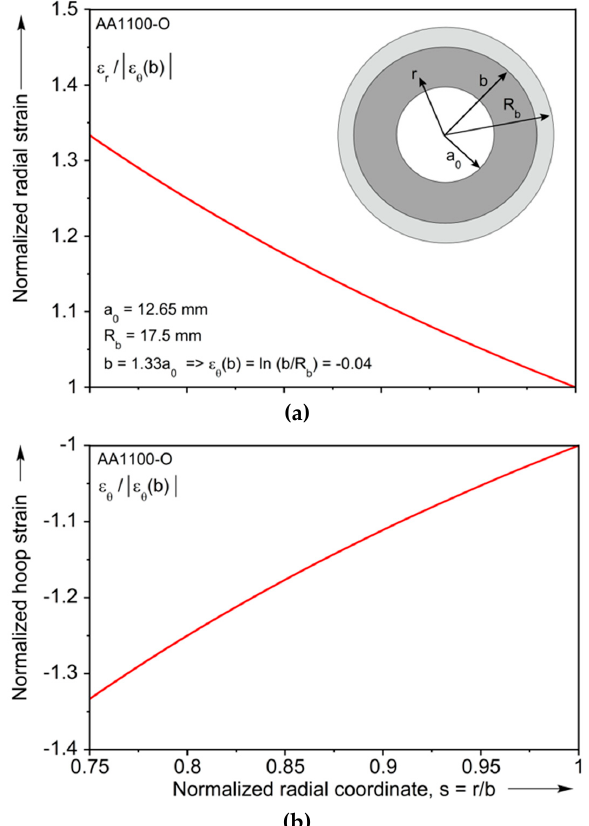
Figure 7. Normalized strain distribution in the flange when the hoop strain at the outer periphery is 0.04. ( a ) Radial strain; ( b ) hoop strain.